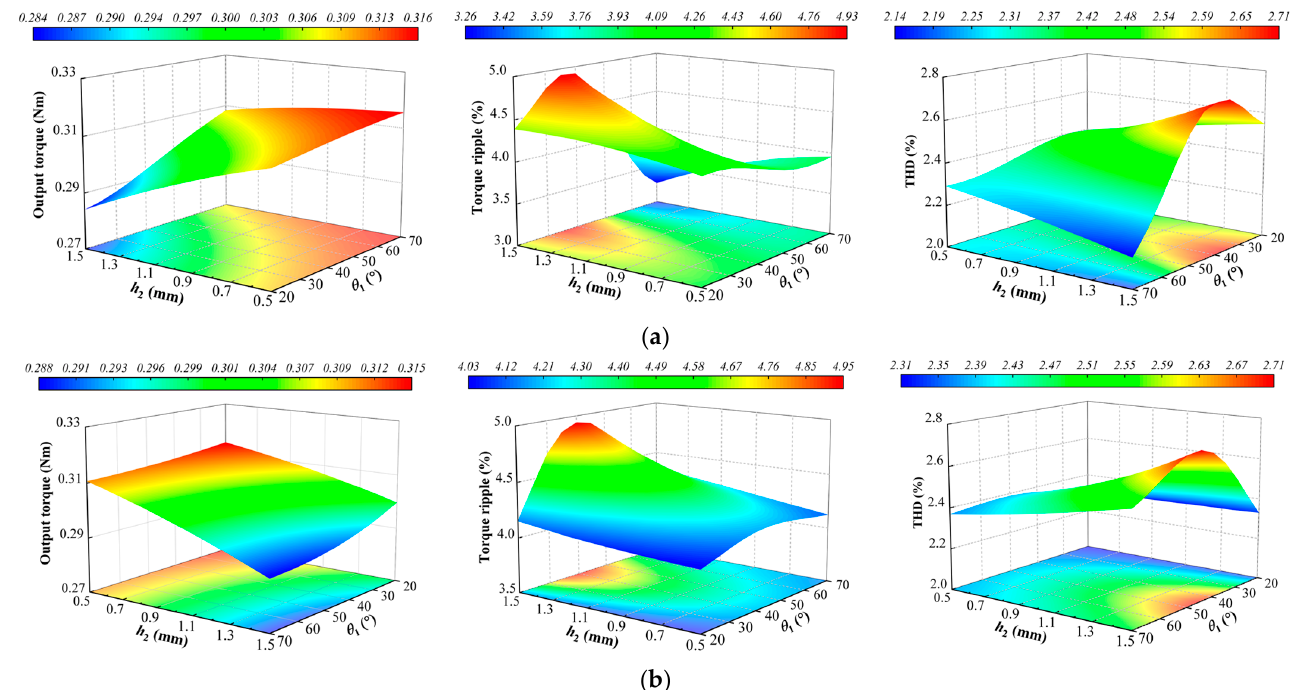
Figure 4. Torque, torque ripple, and THD vs. h 2 and θ 1 . ( a ) SIPM1. ( b ) SIPM2.